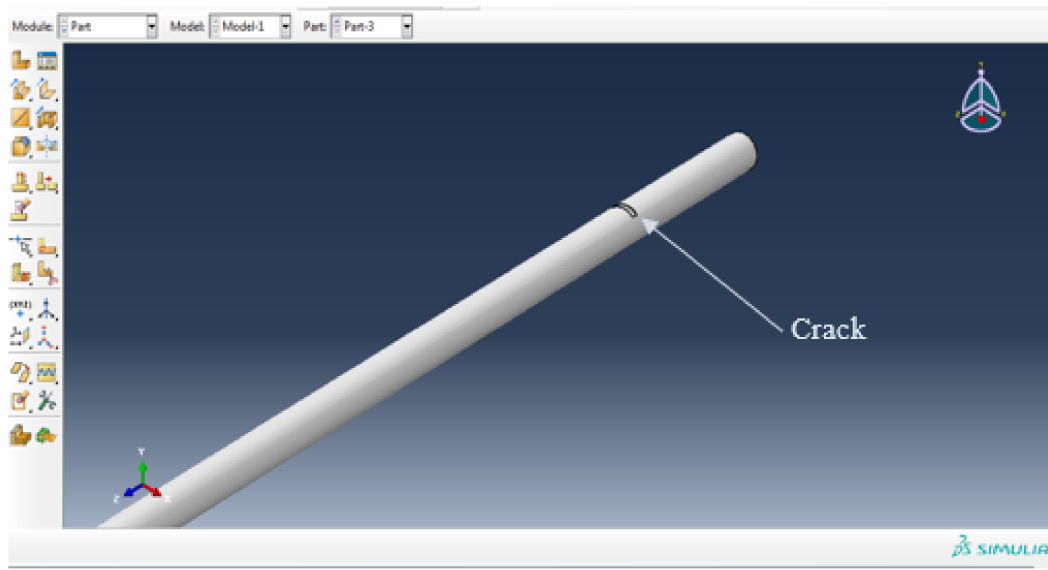
Figure 9. Crack location along the drill